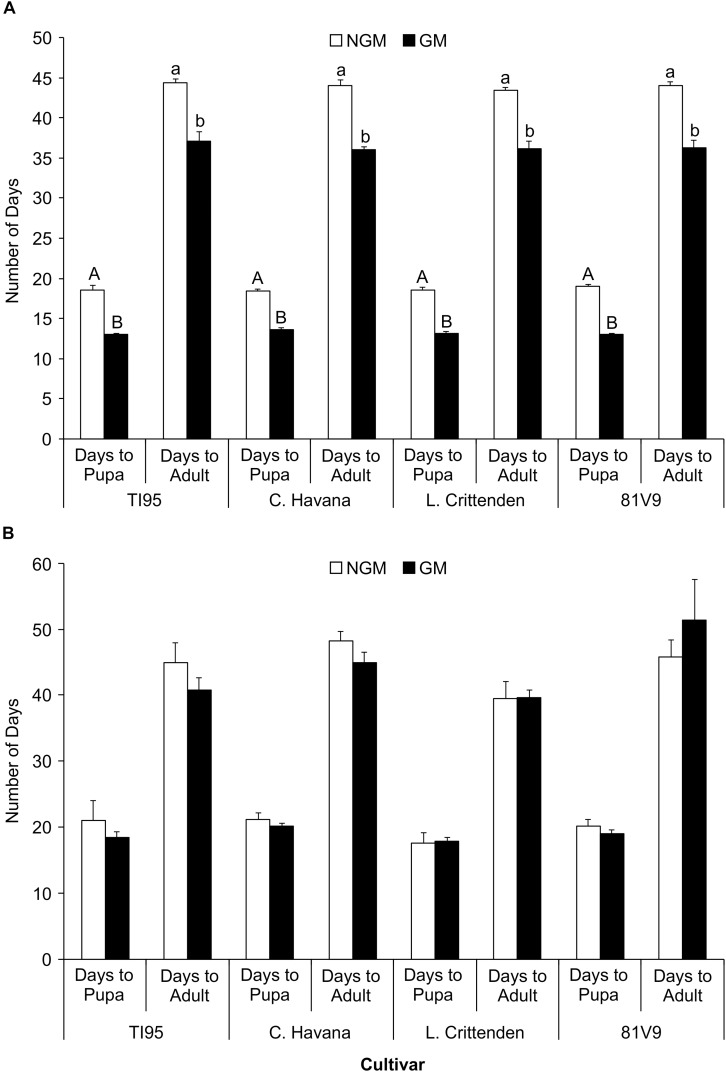
Tobacco hornworm develop faster on transgenic cultivars in the greenhouse, but not in the field. The mean number of days to pupa and to adult stage ± S.E. for tobacco hornworm. (A) greenhouse-grown (N = 20/cultivar) and (B) field-grown plants (N = 20/cultivar). Cultivars with the same uppercase (days to pupa) or lowercase (days to adult) letter in (A) are not statistically different, no letters in (B) indicates no statistical difference among all treatments (2-way ANOVA, Tukey’s pairwise comparison, P < 0.05).